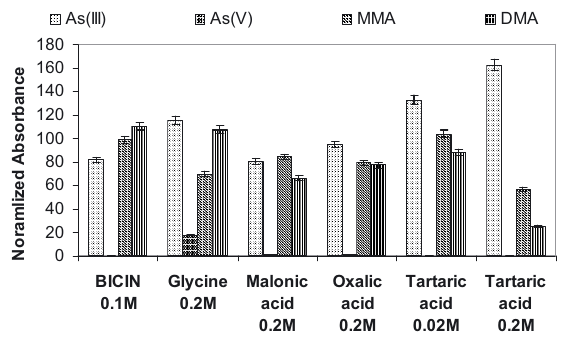
Figure 2. Influence of dicarboxylic acids on generation of arsines. Absorbance signals normalized to aqueous As(III) solu- tions.